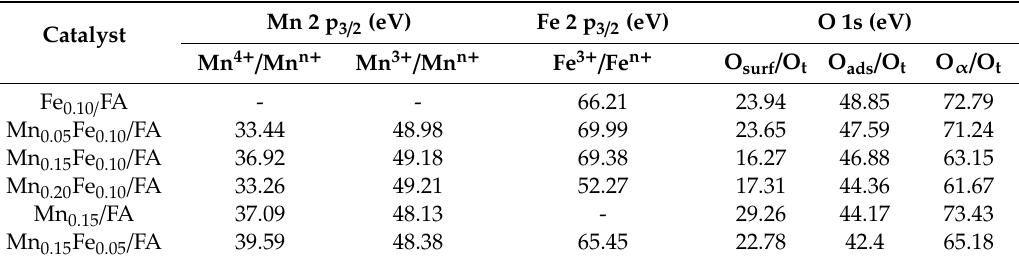
Table 3. The surface elemental concentration of catalysts by XPS